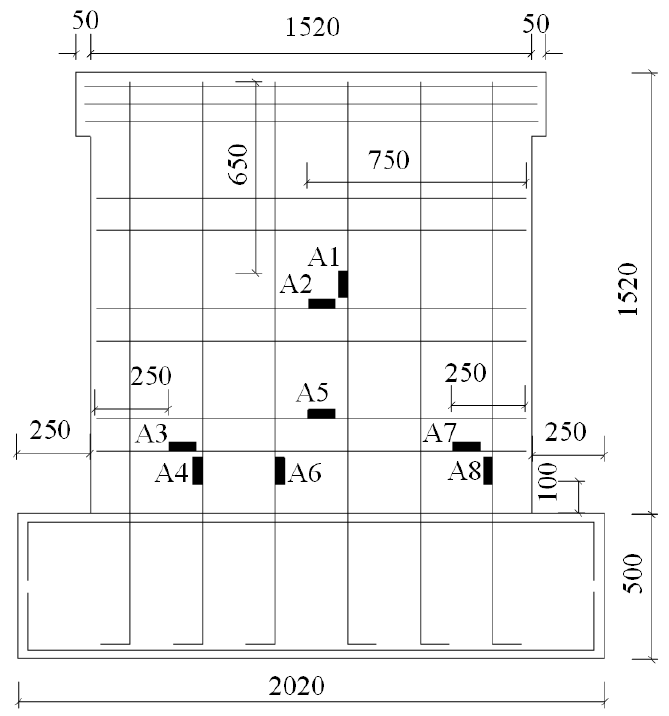
Figure 6. Layout of strain gauges on the reinforcement of CEW.